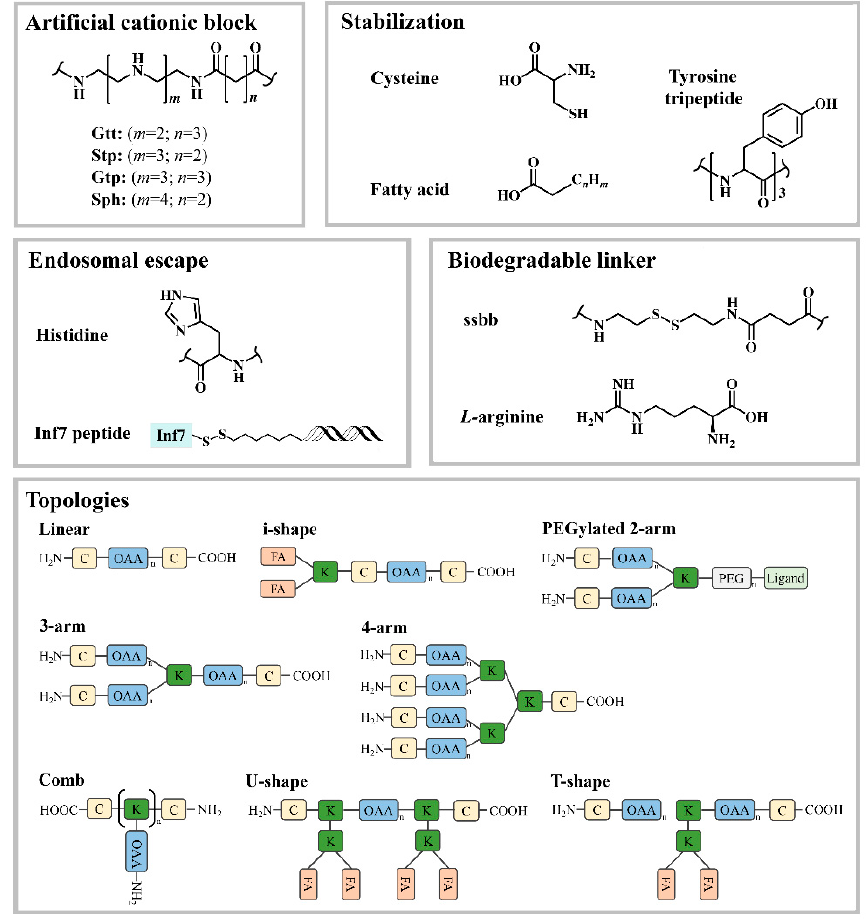
Figure 3. Functional elements for sequence-defined OAAs different topologies. ssbb: Disulfide building block = succinoyl-cystamine; OAA, artificial oligoamino acid; K: Lysine; C: Cysteine; FA: Fatty acid.